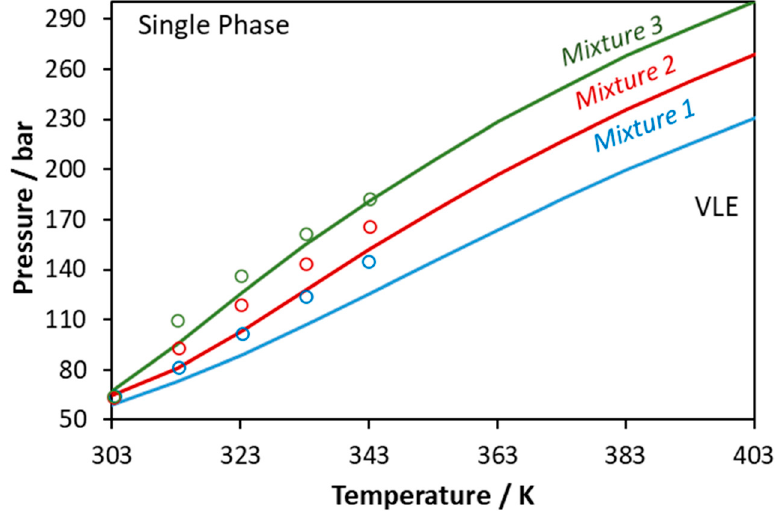
Figure 12. Phase boundaries for CO 2 –methanol–lauric acid ternary system. Experimental data (points, [57]) and CPA predictions using the binary interaction parameters of Table 6 (Mixture 1: x CO2 = 0.6675, x methanol = 0.2217, x lauric acid = 0.1108; Mixture 2: x CO2 = 0.7492, x methanol = 0.1672, x lauric acid = 0.0836; Mixture 3: x CO2 = 0.8248, x methanol = 0.1168, x lauric acid = 0.0584).